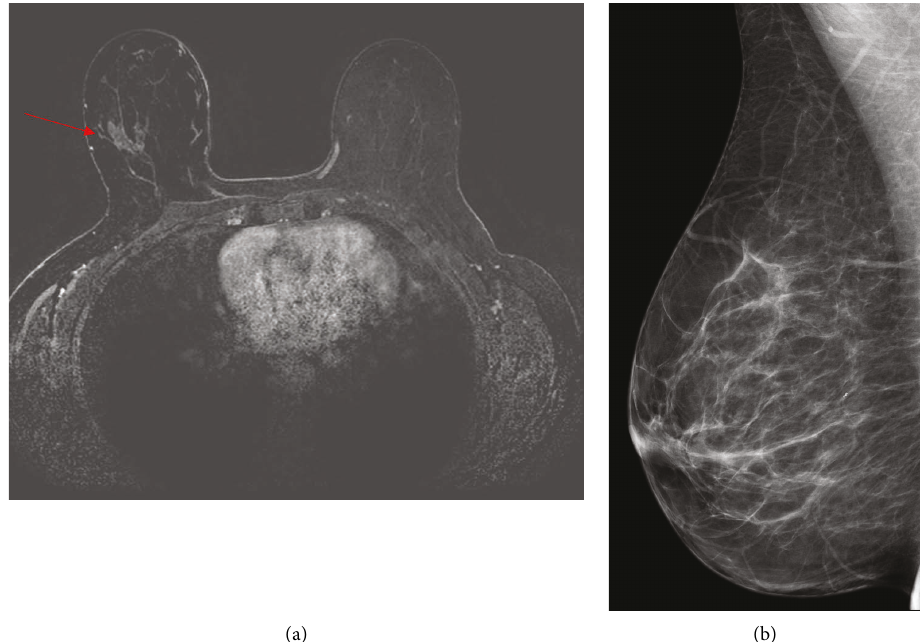
Figure 3: 43 year-old BRCA2 carrier, undergoing annual MRI, showing a new NME in the right breast (A axial image, red arrow). MLO view of the right breast shows no corresponding